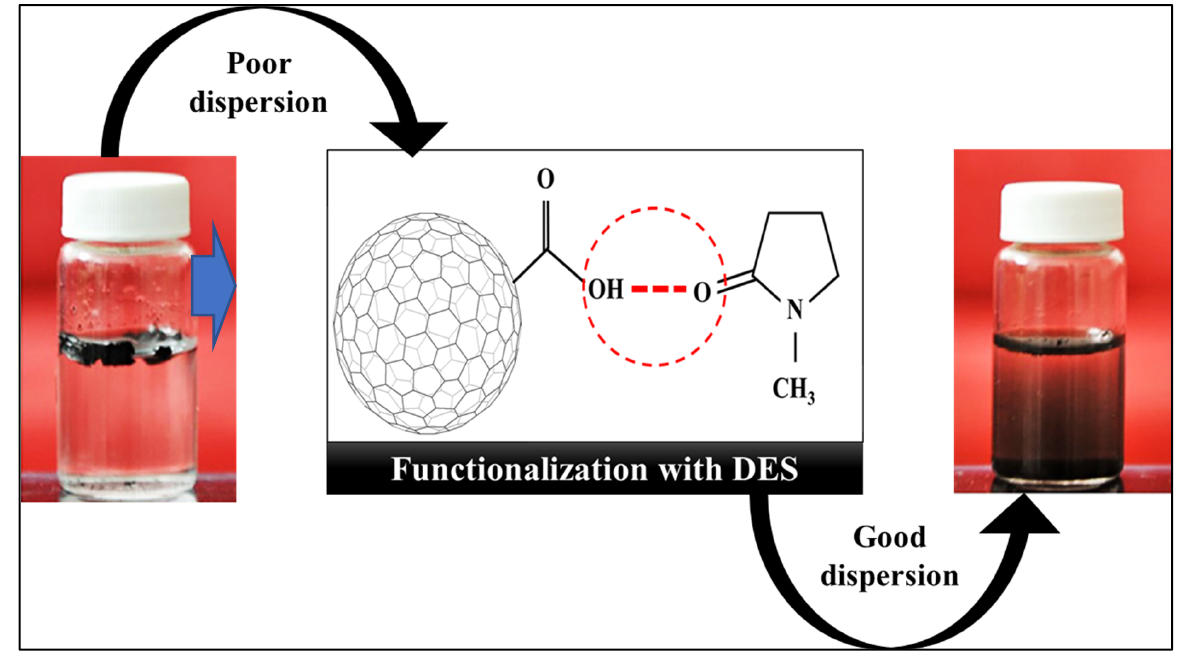
Figure 4. The effect of DESs’ functional groups on the dispersion of CNS.